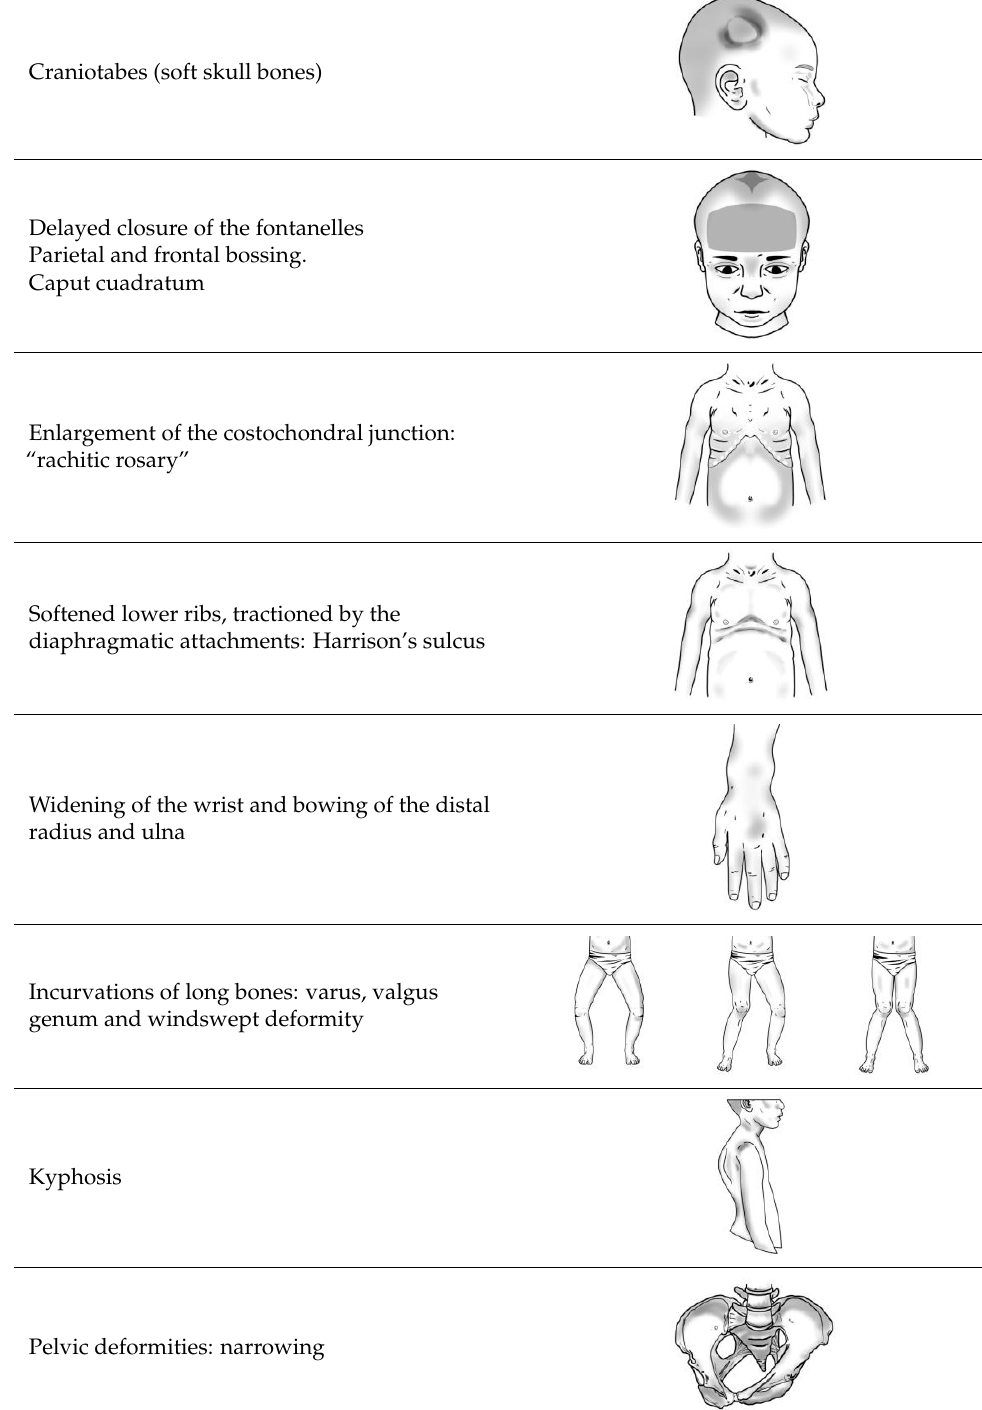
Table 3. Skeletal signs of nutritional rickets: denomination and illustrative drawings. Craniotabes (soft skull bones)